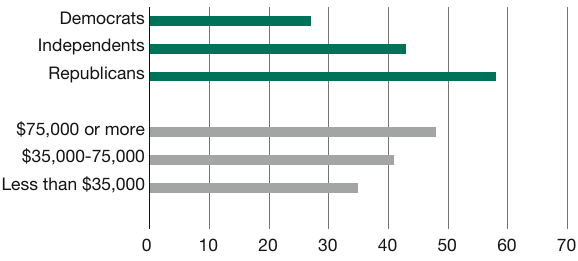
Figure 3 Do you favor or oppose the federal government taking steps to help prevent people from losing their homes because they cannot pay their mortgage